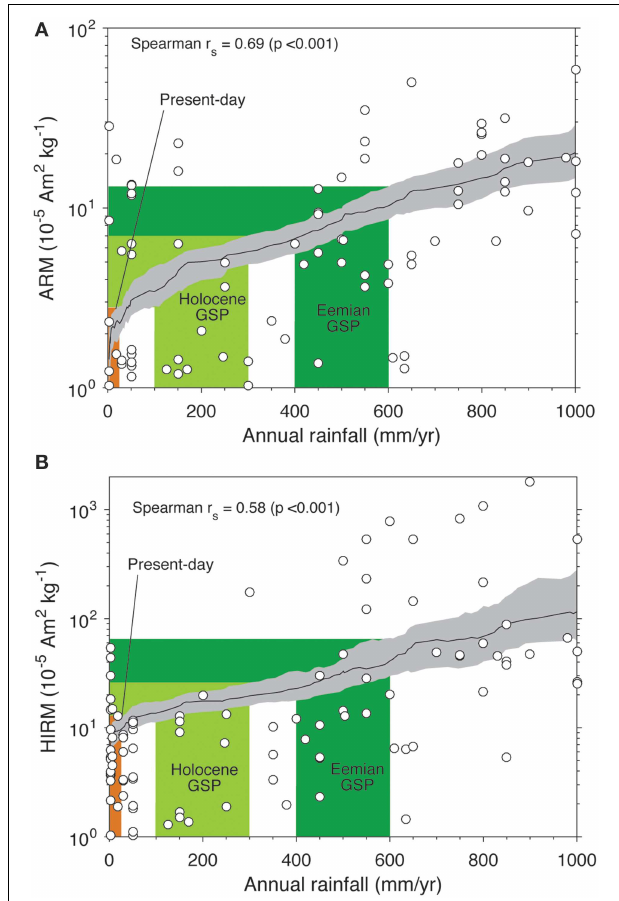
FIGURE 2 | Variations in (A) ARM values (proxy for the concentration of pedogenic magnetite/maghemite) and (B) HIRM values (proxy for the concentration of pedogenic hematite) of Saharan surface sediments as a function of precipitation. Both ARM and HIRM exhibit a significant Spearman rank correlation with precipitation. The black lines indicate the best fits calculated following a nonparametric regression based on the rank transform of Conover and Iman (1981). The shaded regions are the 95% confidence intervals for the regressions. Orange, light green and dark green fields indicate the range of precipitation and associated ARM and HIRM values associated with present-day, Holocene GSP and Eemian GSP conditions,